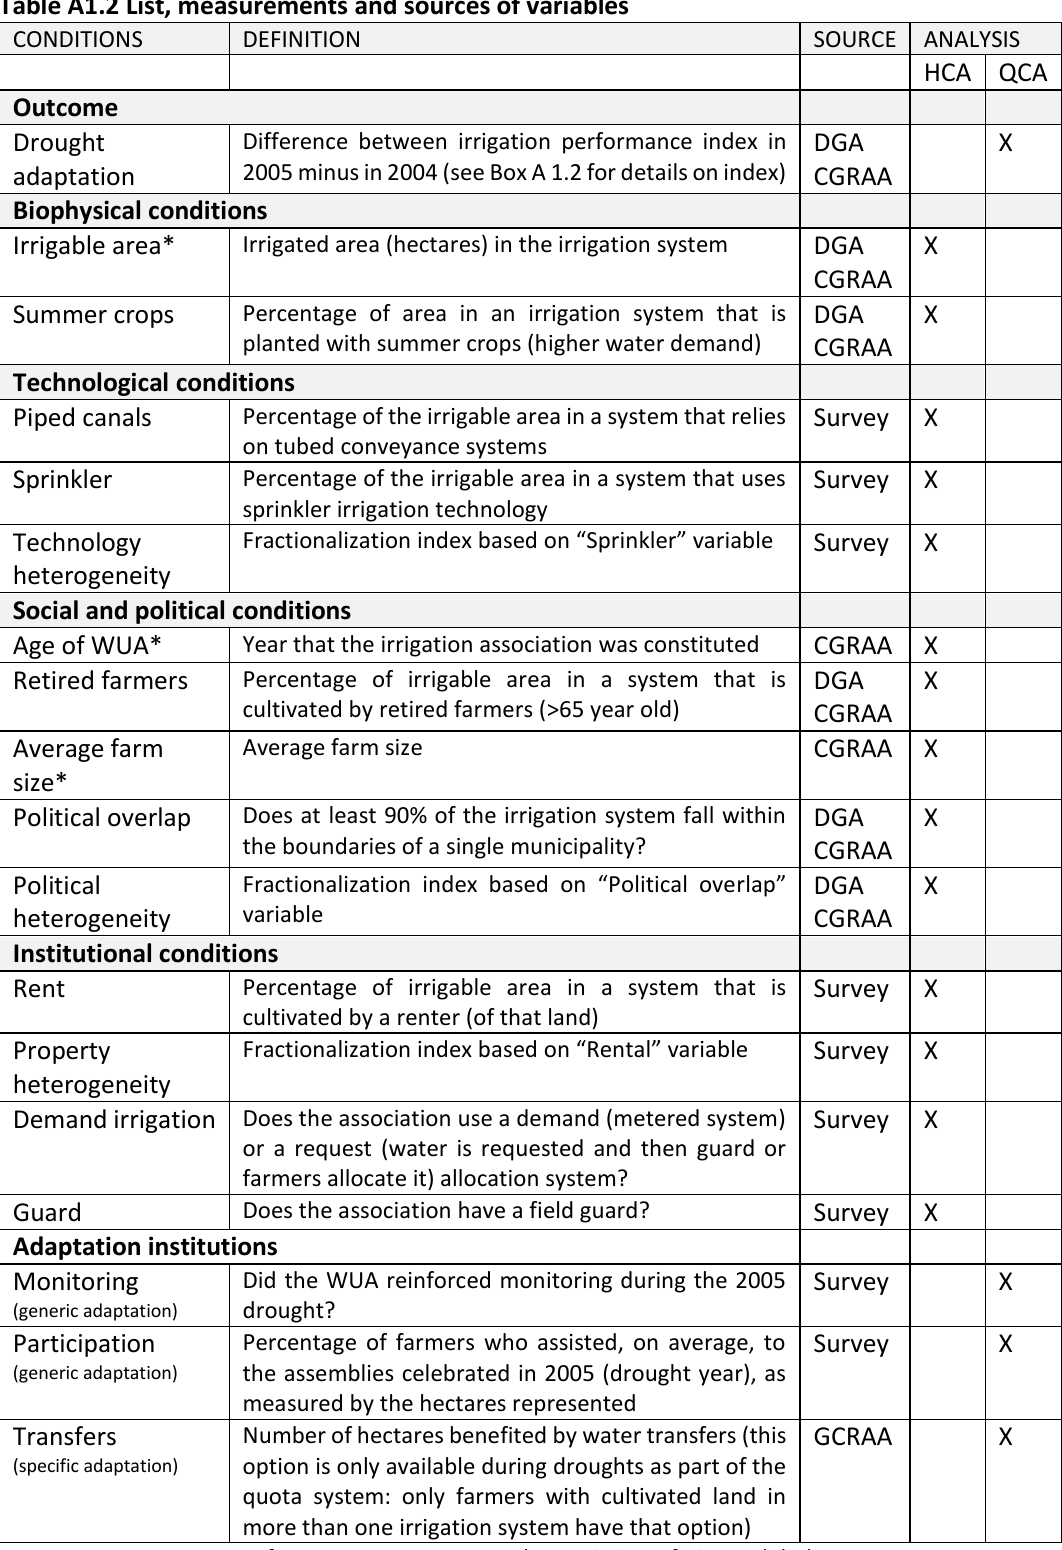
Table A1.2 List, measurements and sources of variables